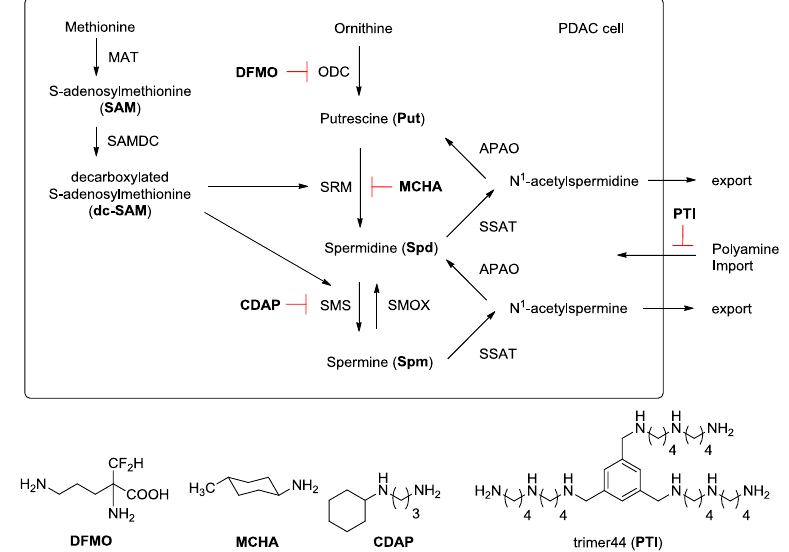
Figure 1. Polyamine Metabolism and Transport. Ornithine is converted to putrescine via